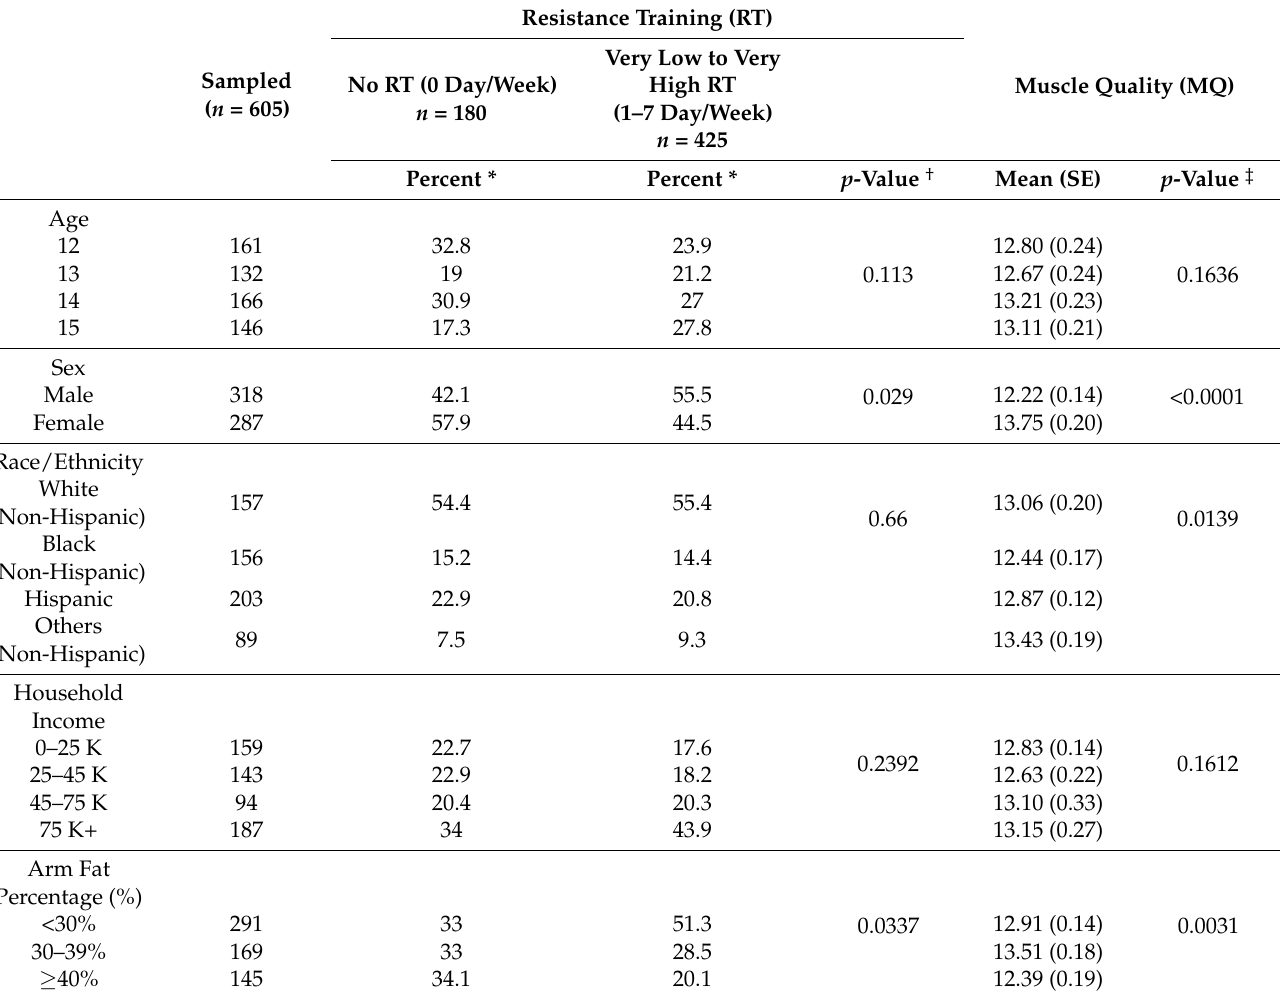
Table 1. Association between characteristics with resistance training and muscle quality (age 12–15 years